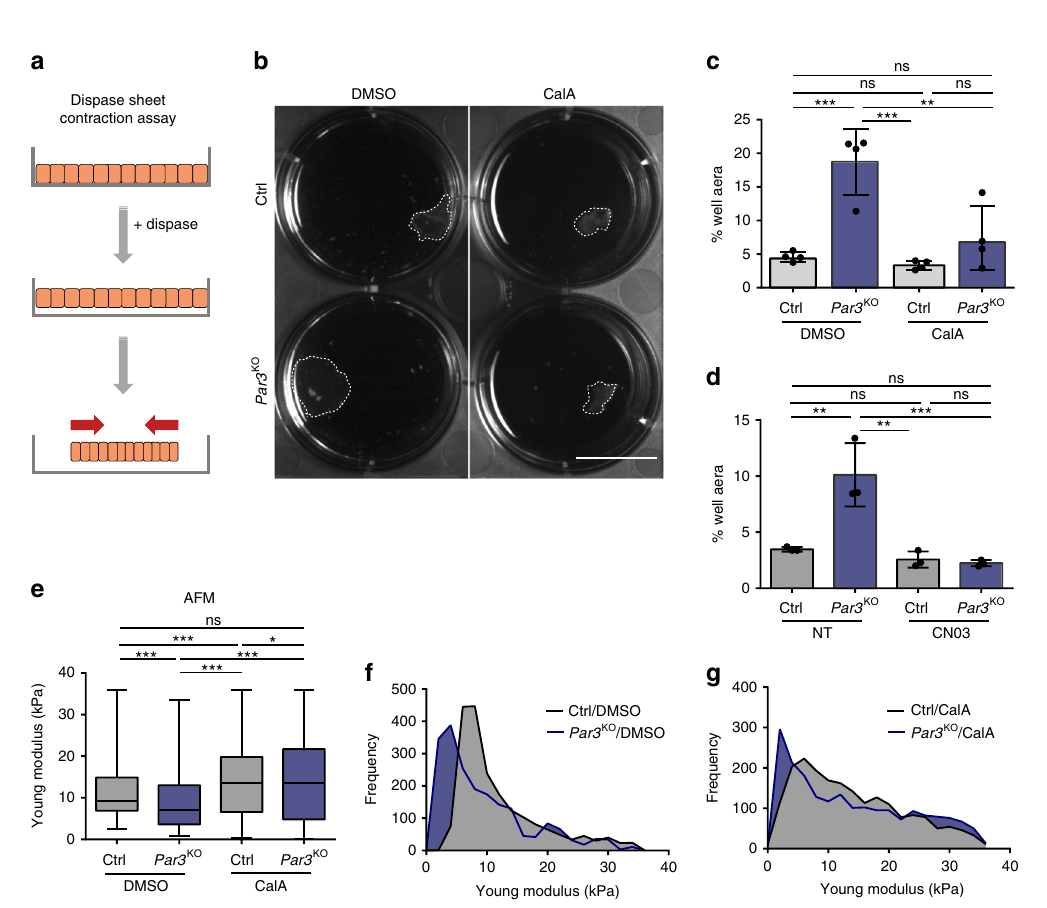
Fig. 5 Re-establishment of actomyosin contractility rescues viscoelastic properties in Par3-de fi cient cells. a Schematic representation of dispase sheet contraction assay. b Representative images of dispase sheet contraction assay 24 h after 1 nM CalA treatment using control and Par3 KO keratinocytes. Scale bar: 15 mm. c Quanti fi cation of keratinocyte sheet area after dispase sheet contraction assay 24 h following treatment with CalA (1 nM). n = 4 independent experiments; ** p = 0.0029, *** p = 0.0004 (Ctrl/DMSO vs Par3 KO/DMSO), *** p = 0.0002 ( Par3 KO/DMSO vs. Ctrl/CalA) mean ± SD;